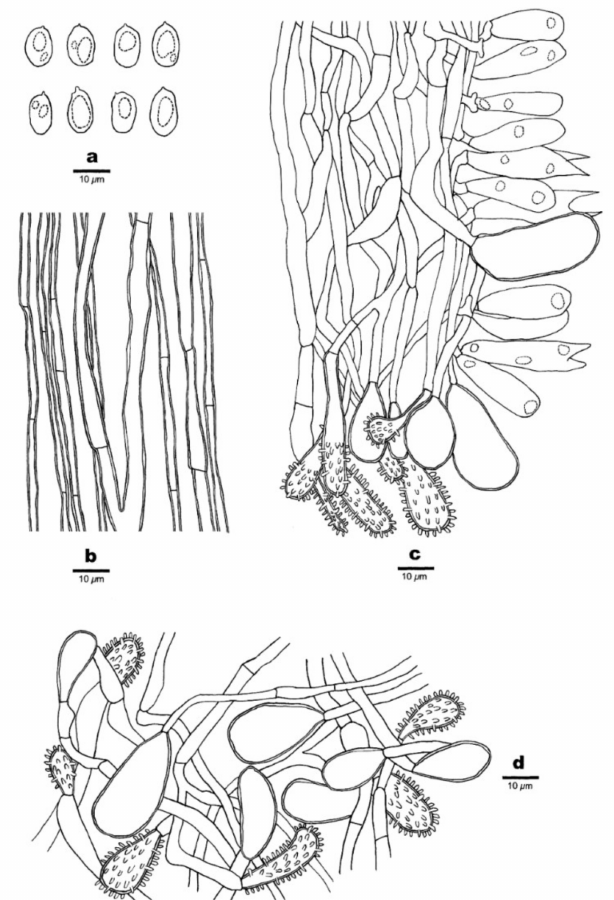
Figure 12. Microscopic structures of Favolaschia longistipitata (Dai 19799, holotype). ( a ) Basidiospores. ( b ) Medullary hyphae of the stipe. ( c ) Hyphae at the edge of pores showing gloeocystidia, acantho- cystida, basidia, and basidioles. ( d ) Hyphae of the pileus cortex, composed of a hymeniform layer of acanthocysts and